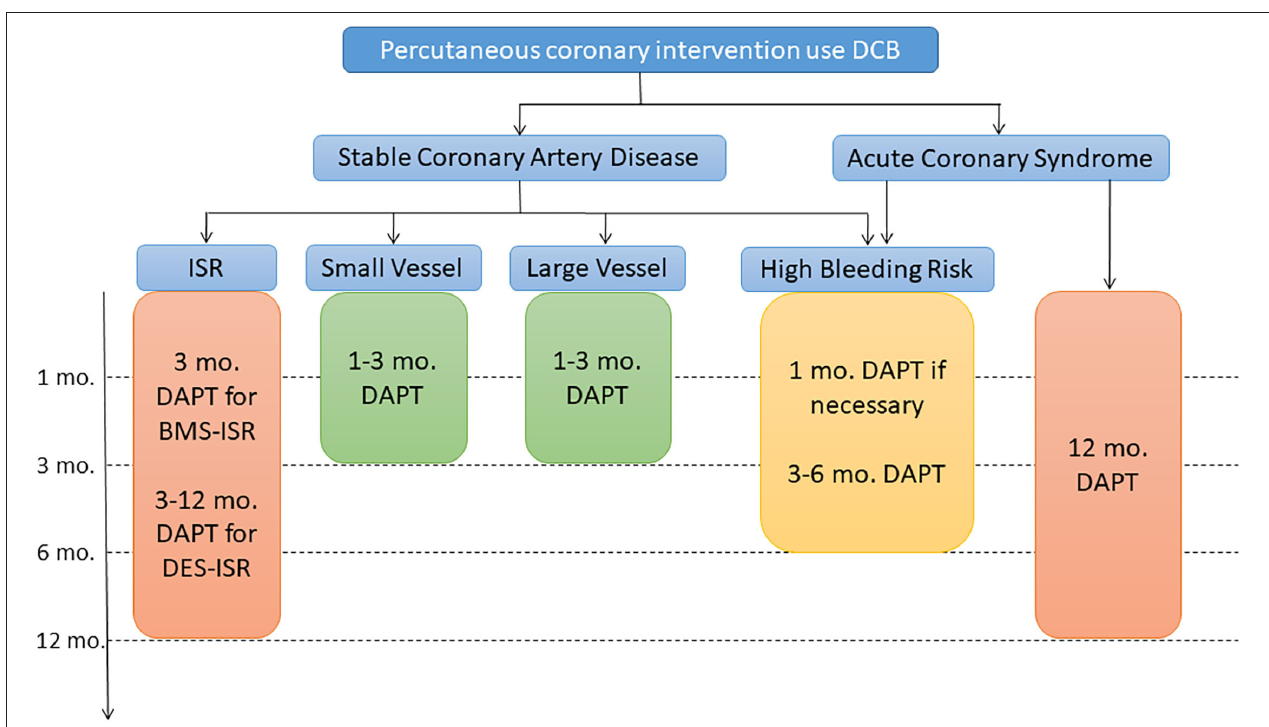
FIGURE 2 | Algorithm for dual antiplatelet therapy (DAPT) in patients treated with percutaneous coronary intervention and only using DCB. DCB, drug-coated balloon; ISR, in-stent restenosis; CTO, chronic total occlusions. High bleeding risk is considered an increased risk of spontaneous bleeding during DAPT (e.g., PRECISE-DTPA score ≥